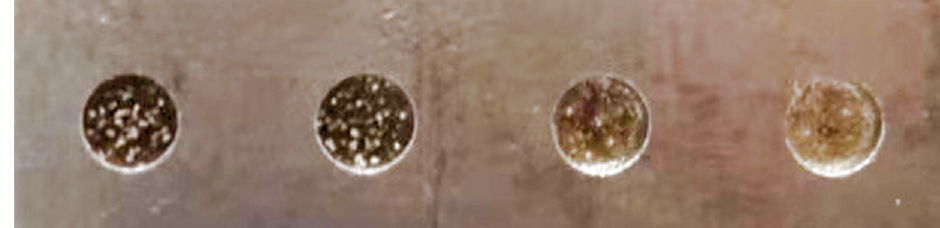
Figure 15. Image of machined workpiece.